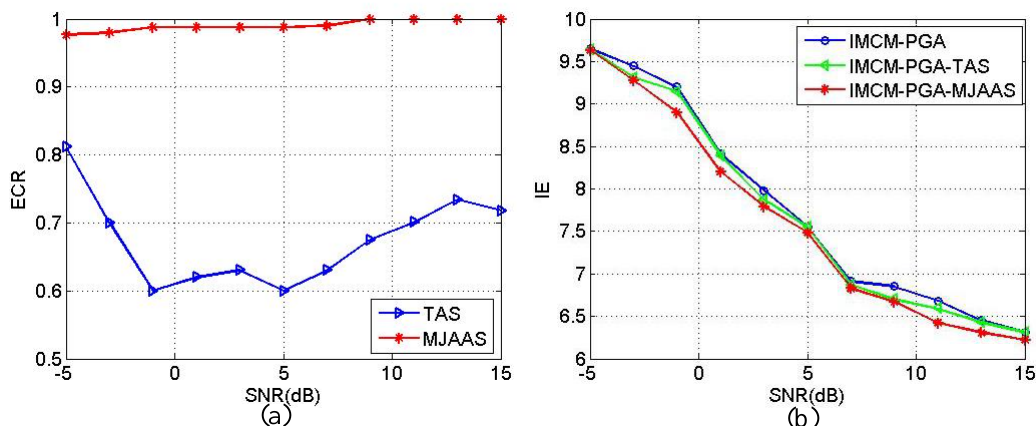
Figure 11. The relationship curve between ECR and SNR and the relationship curve between IE and SNR. ( a ) ECR. ( b )